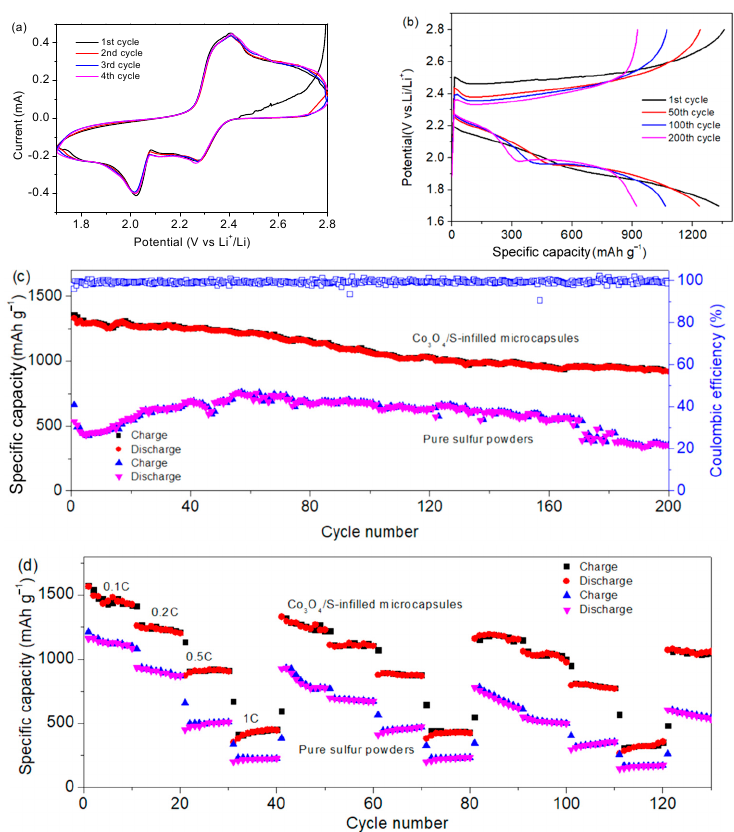
Figure 7. ( a ) CV curves of Co 3 O 4 /S-infilled microcapsules-based Li-S battery scanning at a rate of 0.1 mV s − 1 . ( b ) Cycling curves at 0.5C. ( c ) Cycling performance at a rate of 0.5C. ( d ) Rate-performance of different samples. Table 1. Comparison on the electrochemical performance of some composite-based cathodes.